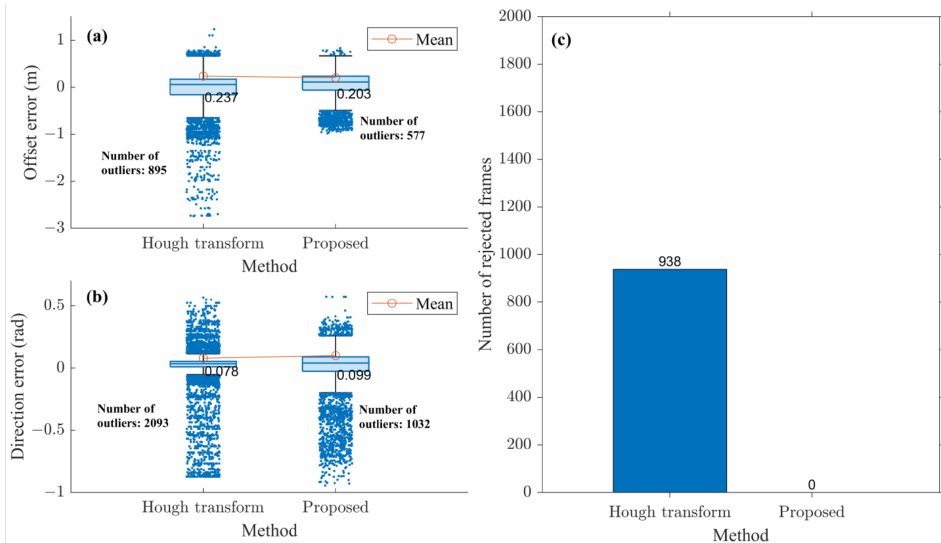
Figure 11. The error of the proposed method and the Hough transform method for dataset 1: ( a ) offset error; ( b ) direction error; ( c ) number of rejected frames. Note: The red circles in ( a , b ) represent the corresponding absolute average error, respectively.